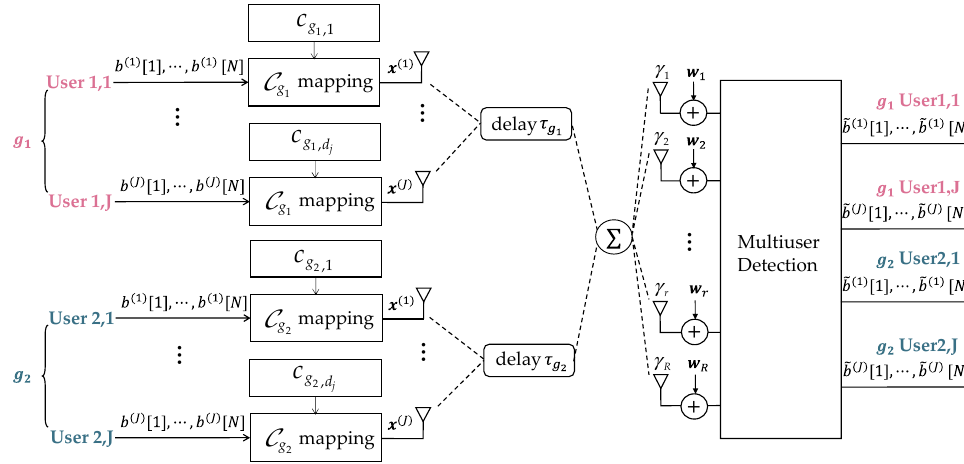
Figure 4. Uplink asynchronous MIMO-SCMA multi-user group system.